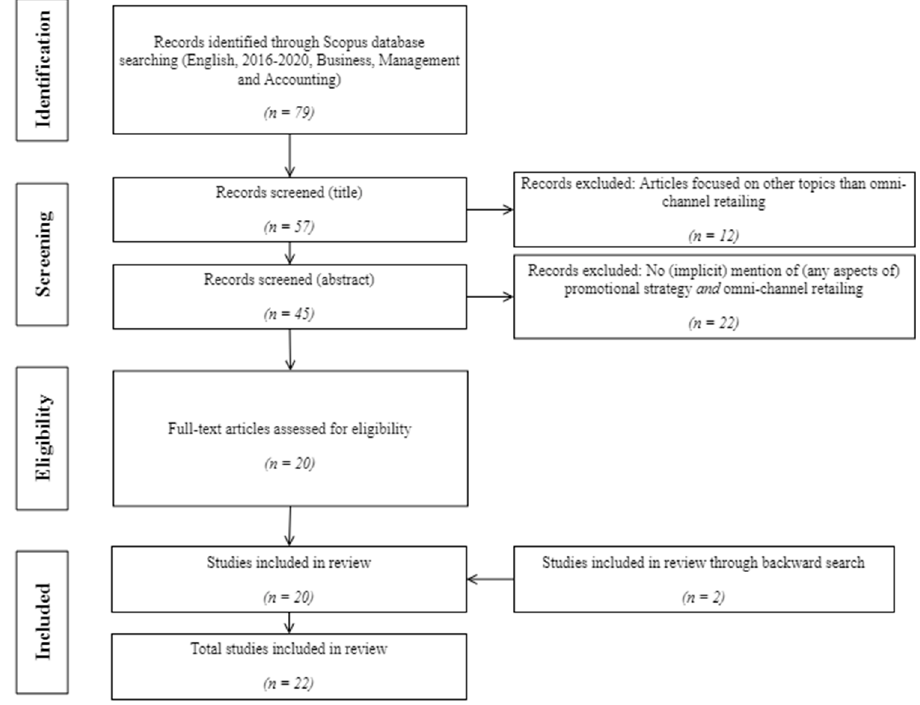
Figure 1. Overview of the literature search process based on PRISMA.